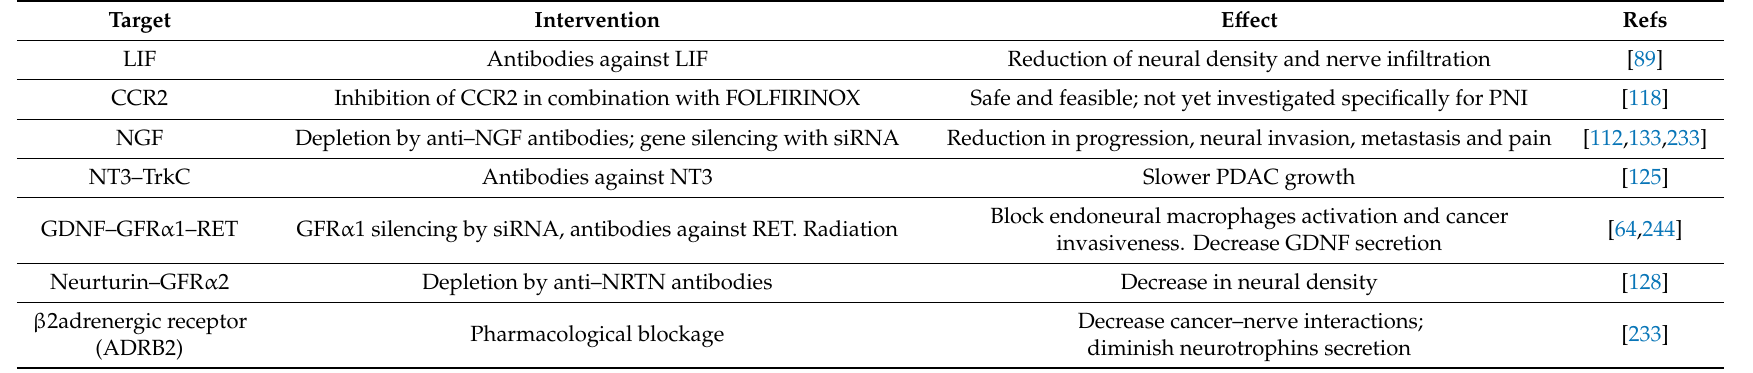
Table 2. Molecules involved in PNI–translational